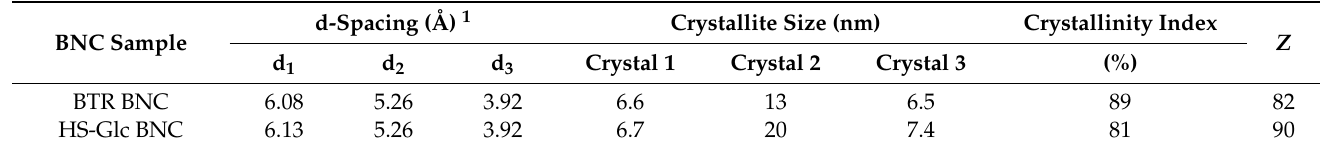
Table 6. Parameters obtained from the XRD analysis of the BNC